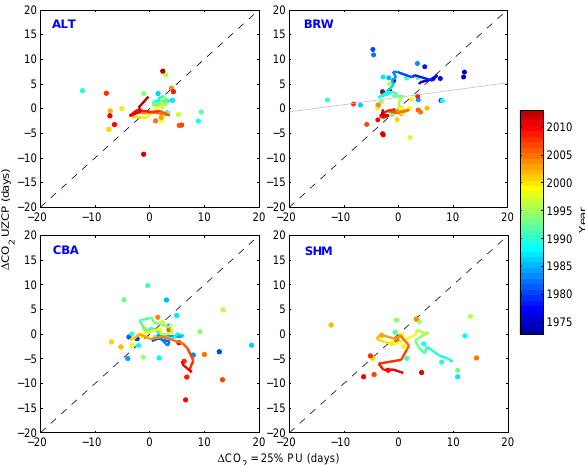
Figure 7. Scatterplots of the (cid:49) t CO 2 =25% PU (spring phase) and (cid:49) t CO 2 UZCP (autumn phase) (days) at four high northern latitude sites (see main text). The coloured lines show the trajectory of the 2-year running mean of the scatterplot, where colours represent the year of measurement.